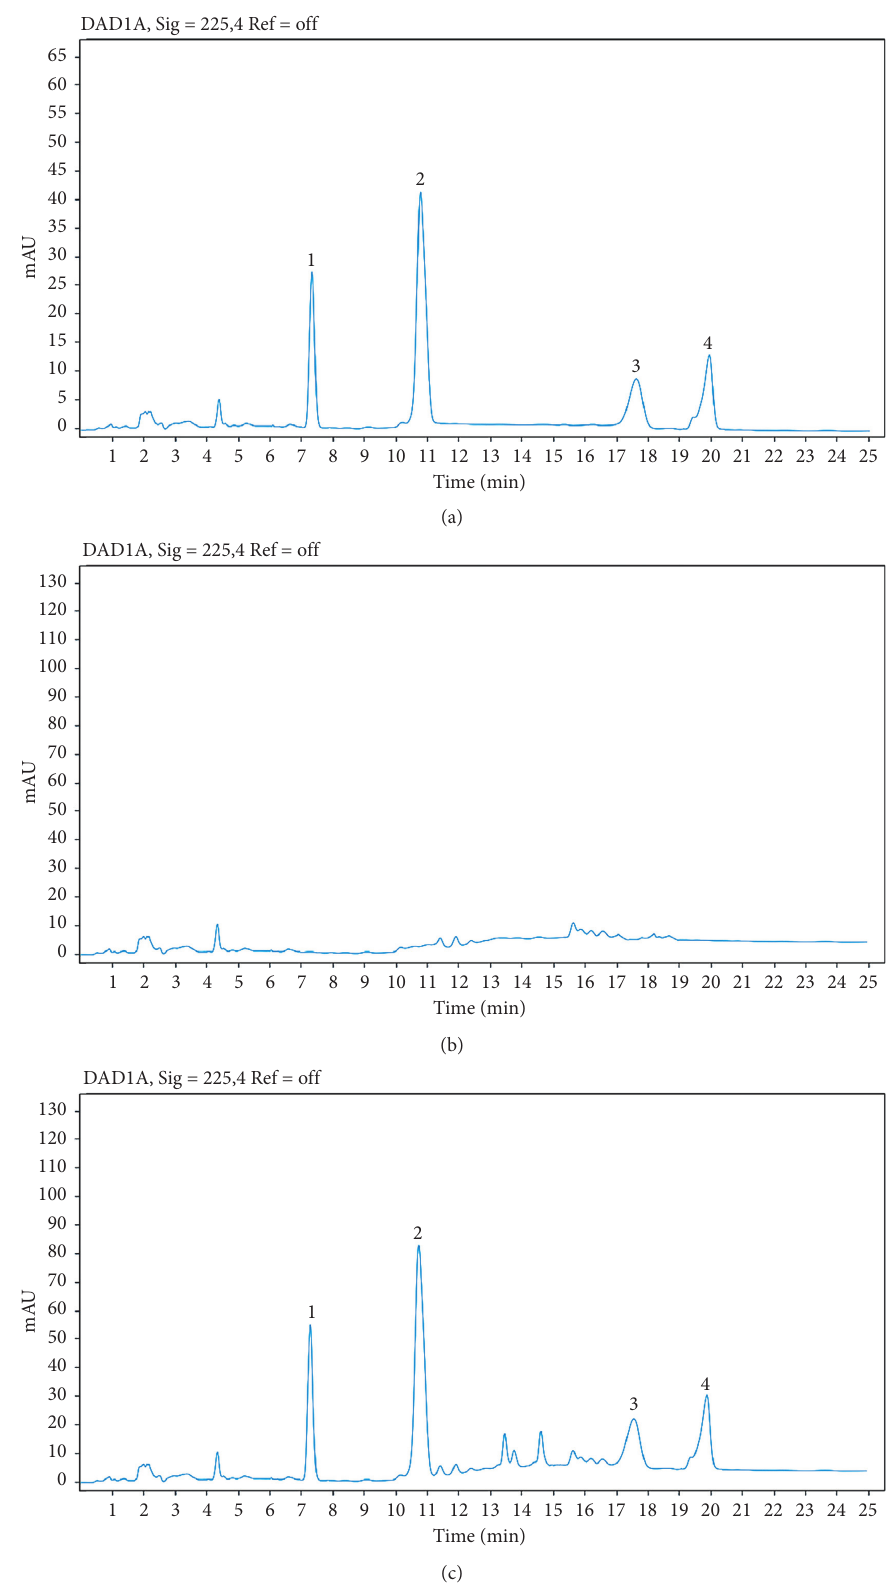
Figure 1: HPLC chromatograms. (a) Standard solution, (b) blank sample, and (c) spiked sample (10 μ g/kg). 1 AFB1, 2 AFB2, 3 ST, and 4